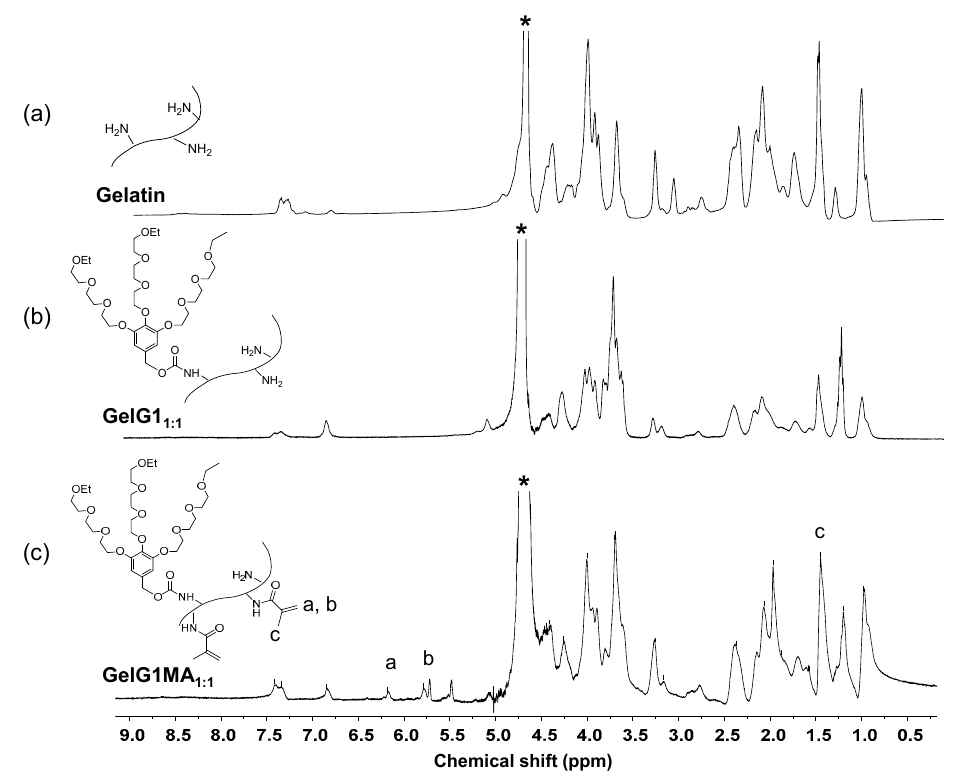
Figure 2. 1 H NMR spectra of naked gelatin ( a ), GelG1 1:1 ( b ) and GelG1MA 1:1 ( c ) in D 2 O. Solvent signals are marked with asterisk (*).